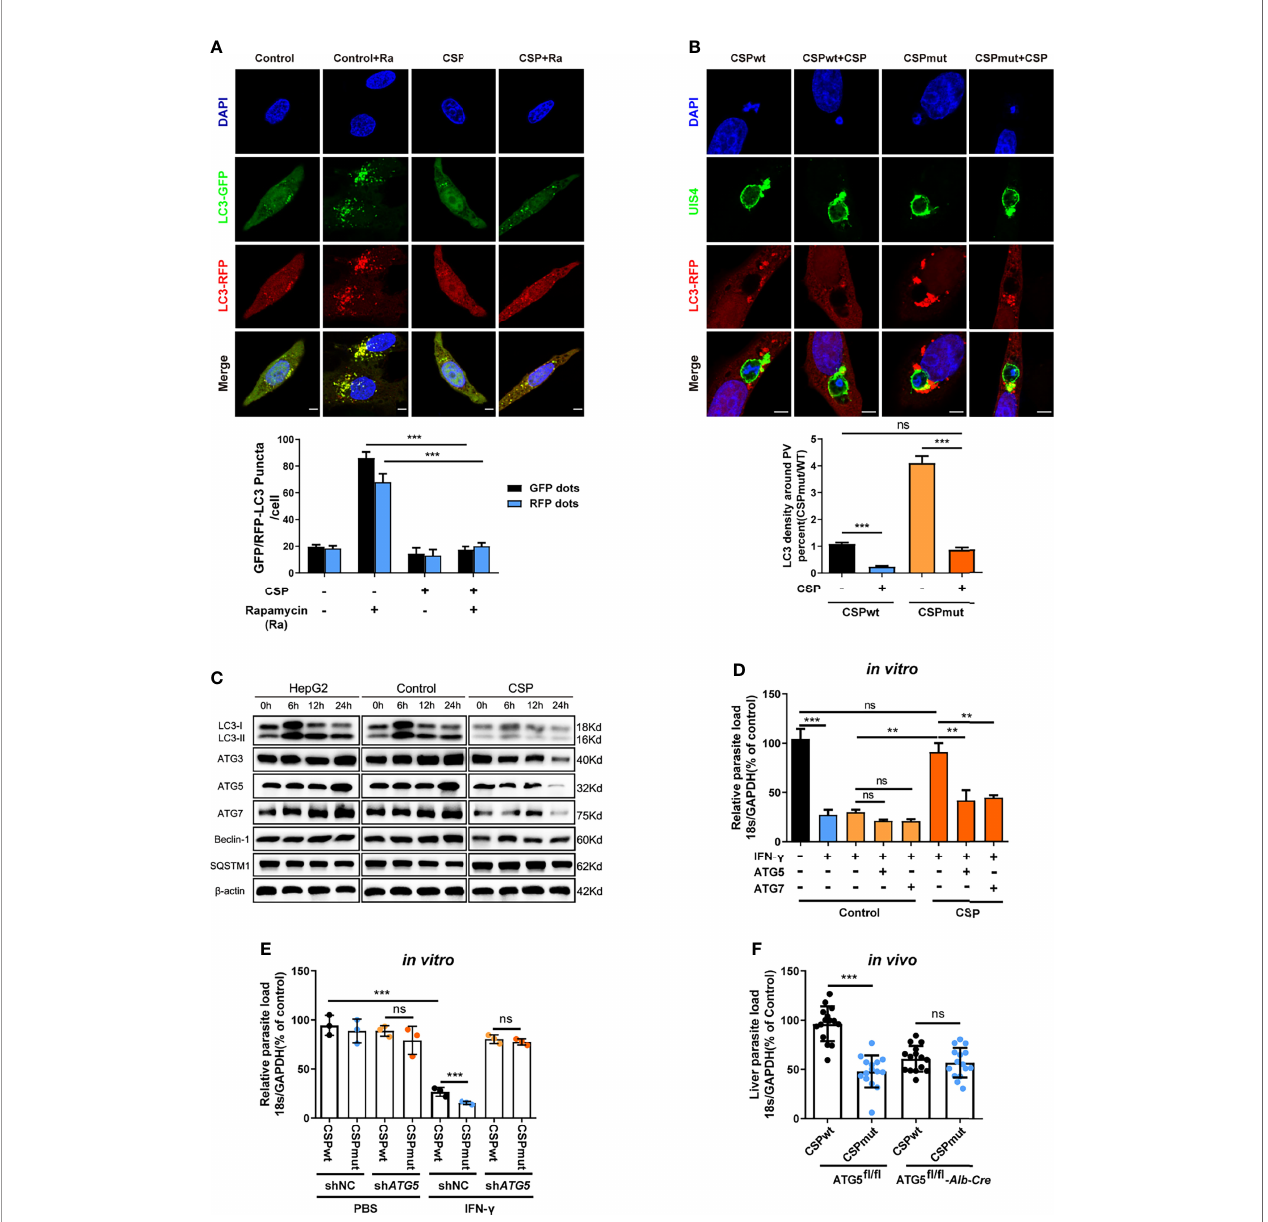
FIGURE 3 | CSP inhibits the IFN- g -mediated suppression of EEFs by the downregulation of ATGs. (A) 1.2 × 10 5 control and CSP-stably transfected HepG2 cells were infected with Ad-mRFP-GFP-LC3 virus, and then treated with the autophagy inducer rapamycin for 24 h. Both LC3-RFP or LC3-GFP puncta in HepG2 cells were imaged ( up ) and quali fi ed ( down ). Scale bar = 5 m m, n=60. (B) 1.2 × 10 5 control and CSP-stably transfected HepG2 cells were transiently transfected with LC3-RFP plasmid, and then incubated with 4 × 10 4 CSP wt or CSP mut sporozoites for 24 h. Cells were fi xed and stained with anti-UIS4, and LC3 surrounding the EEFs was observed under confocal microscopy ( up ), and the intensity of LC3 around PV was quanti fi ed ( down ), Scale bar = 5 m m, n (EEFs) =60. (C) HepG2 (without lentivirus infection), control (infected with Lenti-pCDH control lentivirus and selected by puromycin) and CSP-stably transfected HepG2 cells were treated with rapamycin for the indicated times. Protein levels of ATGs, including LC3I/LC3II, ATG3, ATG5, ATG7, Beclin-1, and p62 (SQSTM1), was determined by western blotting. (D) Control and CSP-stably transfected HepG2 cells transfected with or without ATG5, or ATG7 plasmid, and then treated with 1 U/mL IFN- g and infected with CSP wt sporozoites as above for 46 h. The parasite load in HepG2 cells was determined and compared. Three individual experiments have been performed. (E) HepG2 cells were transiently transfected with Scramble or ATG5 shRNA plasmids, and then treated with 1 U/mL IFN- g and incubated with CSP wt or CSP mut sporozoites as above. 46 h later, the parasite load in the HepaG2 cells was determined and compared. The experiment has been performed for three times. (F) Both control (ATG5 fl / fl ) and ATG5 fl / fl - Alb - Cre mice were infected by intravenous injection with 1,000 CSP wt or CSP mut sporozoites, 46 h later, the liver burden of the two parasites in control and ATG5 fl / fl - Alb - Cre mice were determined and compared. Each dot represents one mouse, n=15. The pooled data of three repeated experiments was presented, data are represented as mean ± SD, and analyzed by a student ’ s t-test, Mann-Whitney U test or One-Way ANOVA; ns, not signi fi cant; **P < 0.01; ***P <